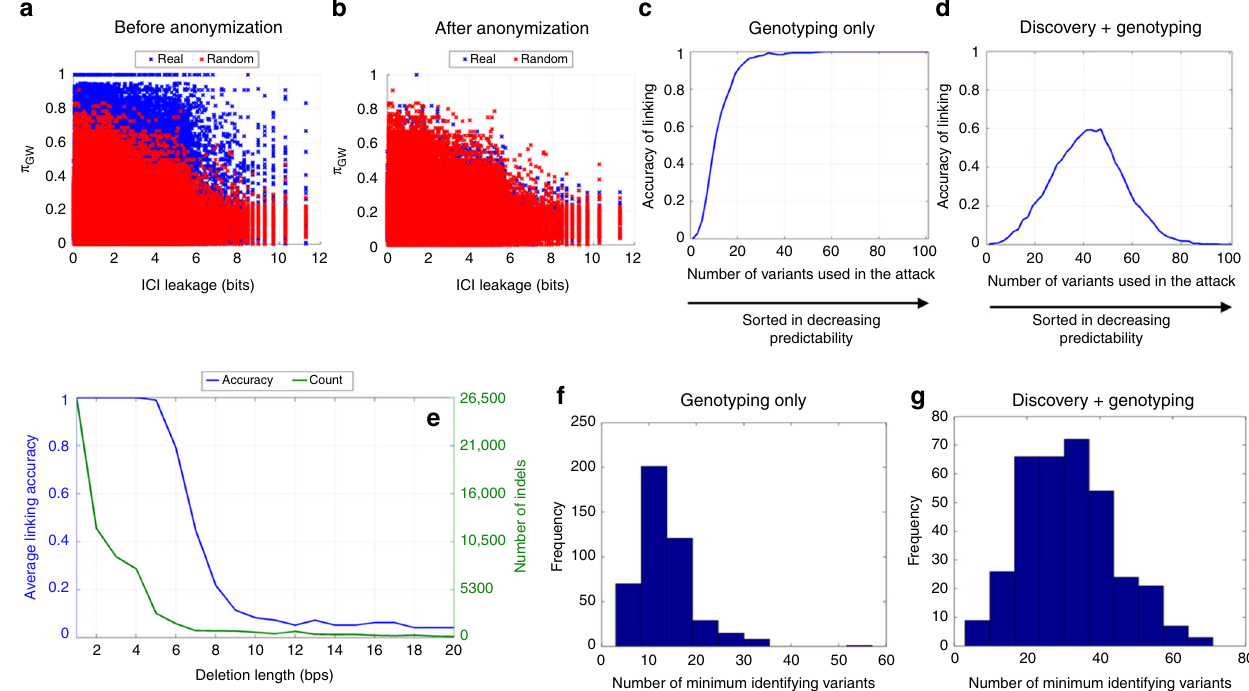
Fig. 2 The accuracy of linking attack on GEUVADIS dataset. a The scatter plot shows the ICI vs. predictability for each deletion (dot). The real data (blue dots) show a much higher predictability compared to randomized data (red dots). b After anonymization of signal pro fi les, the predictability of real data is decreased substantially. c This plot demonstrates the accuracy of linking with genotyping of a known panel. The number of variants used in the attack is shown on the x -axis, while accuracy is shown on the y -axis. The variants are sorted with respect to decreasing predictability. d This shows the linking accuracy when the adversary performs joint discovery and genotyping of deletions to achieve linking. e The blue plot shows the accuracy of linking when indels of a speci fi c length are used in the attack. The green plot shows the distribution of indel lengths. f For the genotyping only scenario, the plot shows the distribution of the minimum number of variants required to identify each individual. The x -axis shows the number of indels and the y -axis shows the frequency of individuals that can be identi fi ed. g For the scenario where adversary discovers the SV panel fi rst and performs genotyping on the discovered panel, the plot shows the distribution of the minimum number of variants required to identify each